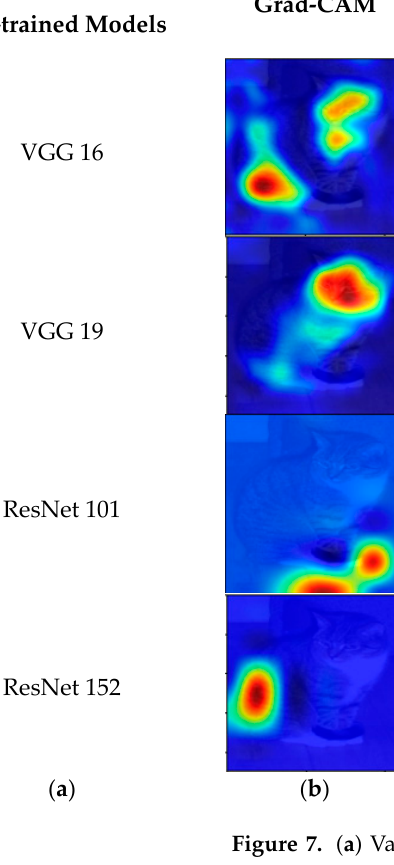
Figure 7. ( a ) Various pre-trained models; ( b ) results of Grad-CAM; ( c ) results of Grad-CAM++; ( d ) bounding box prediction on Grad-CAM++; and ( e ) GradCAM-MLRCNN. Figure 9 shows the results of various pre-trained models, such as VGG 16, VGG 19, ResNet 101, and ResNet 152 with the corresponding results of Grad-CAM, Grad-CAM++, bounding box prediction, and proposed method (GradCAM-MLRCNN) that contains the bounding box with mask prediction concerning the decision tree : (a) various pre-trained models; (b) results of Grad-CAM; (c) results of Grad-CAM++; ( d ) bounding box prediction on Grad-CAM++; and (e) GradCAM-MLRCNN. Figure 10 shows the original image and its corresponding class activation map (CAM).